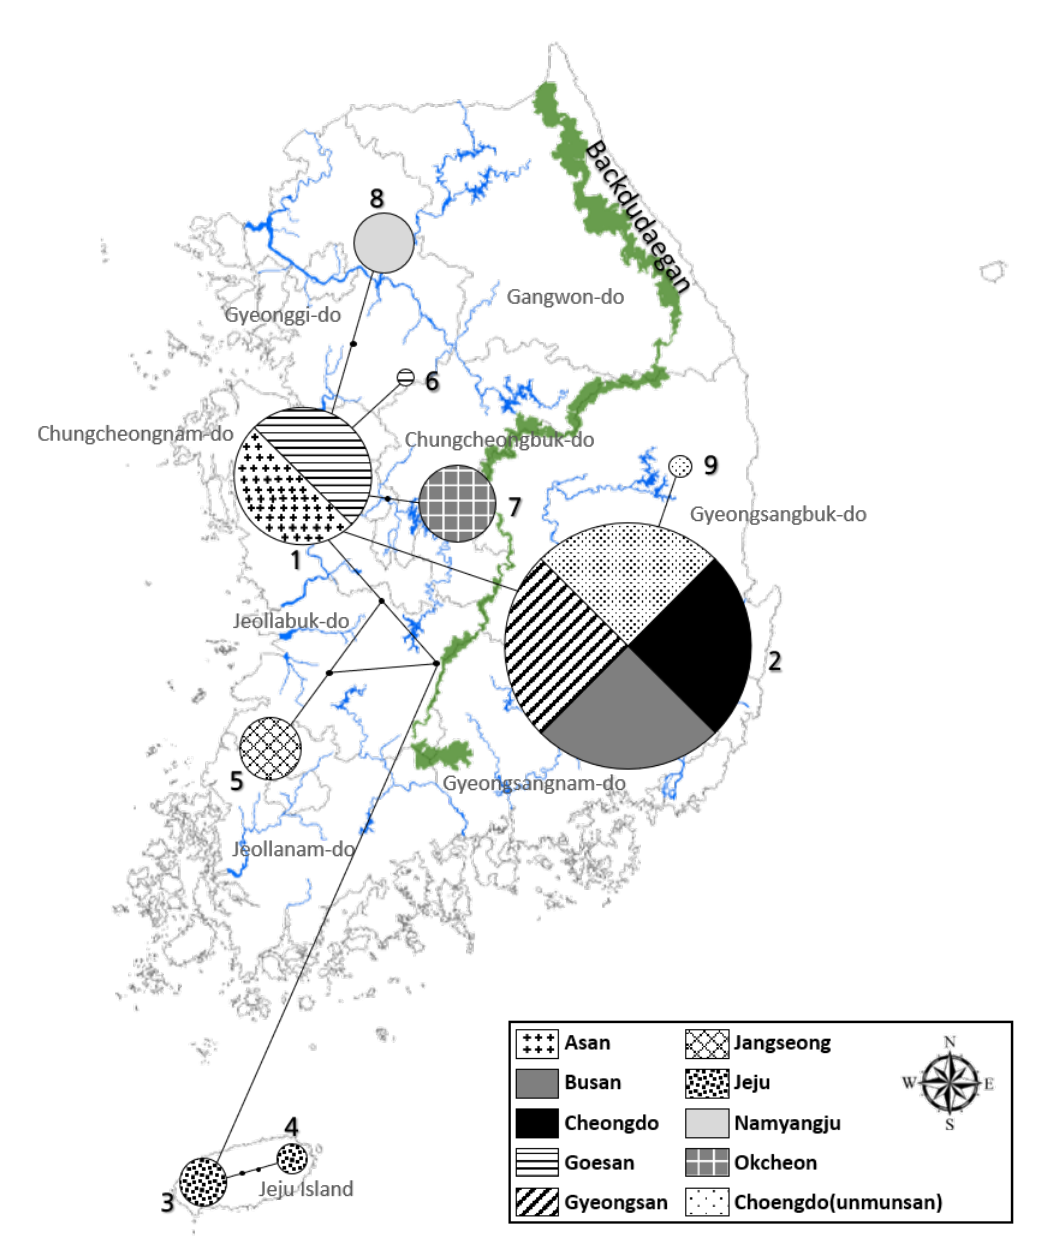
Figure 7. Haplotype network based on the sequence mtDNA 16s rRNA of L. unmunsana.